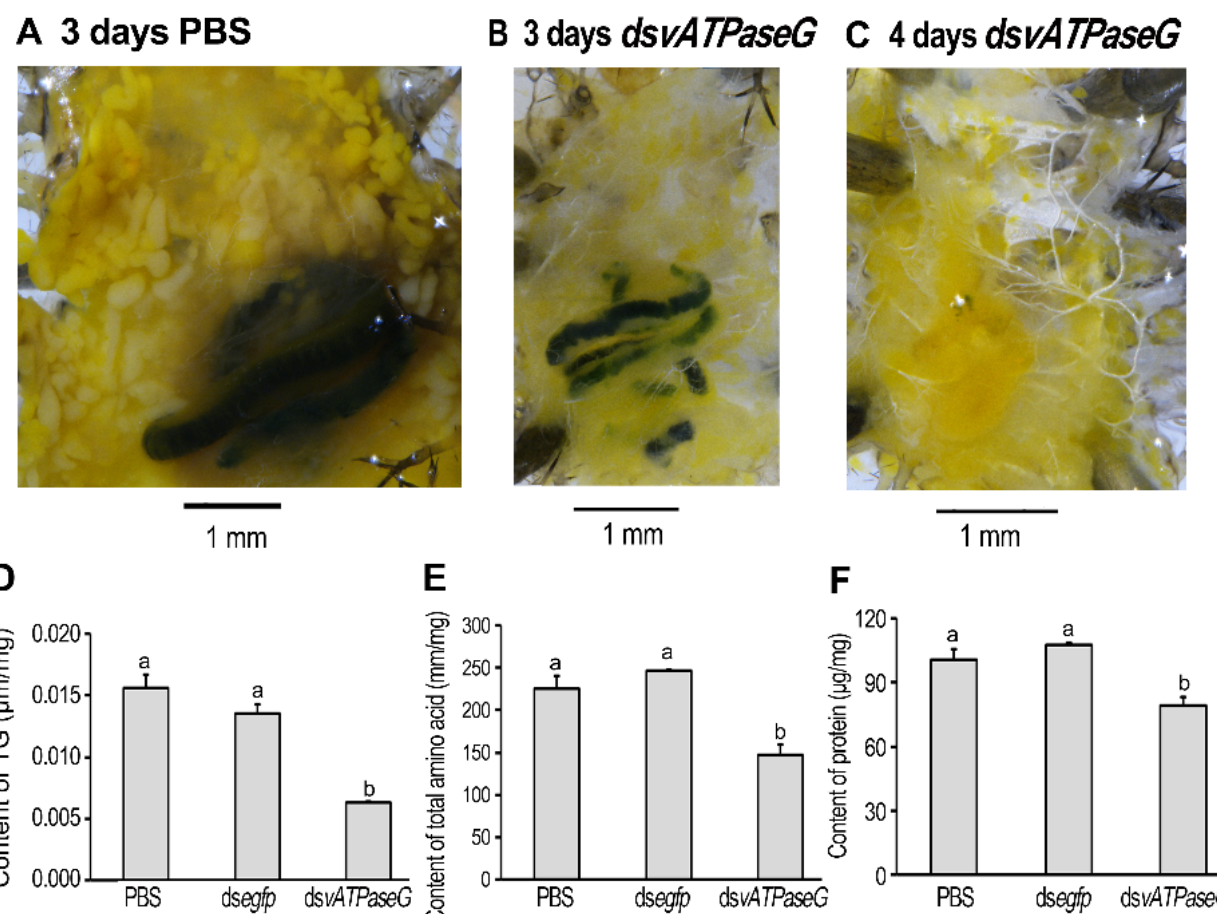
Figure 6. The accumulation of lipid and protein in the HvvATPaseG RNAi larvae in Henosepilachna vigintioctopunctata . The newly-ecdysed fourth instar larvae had ingested PBS-, ds egfp -, and ds vATPaseG -dipped leaves for three days, and in normal foliage for an additional of 2 days. The larval specimens 3 and 4 days after experiment were collected and dissected ( A – C ). The contents of triglyceride, total soluble amino acids and proteins were determined 5 days after experiment ( D – F ). The bars represent values ( ± SE). Different letters indicate significant difference at p value < 0.05 using analysis of variance with the Tukey-Kramer test.